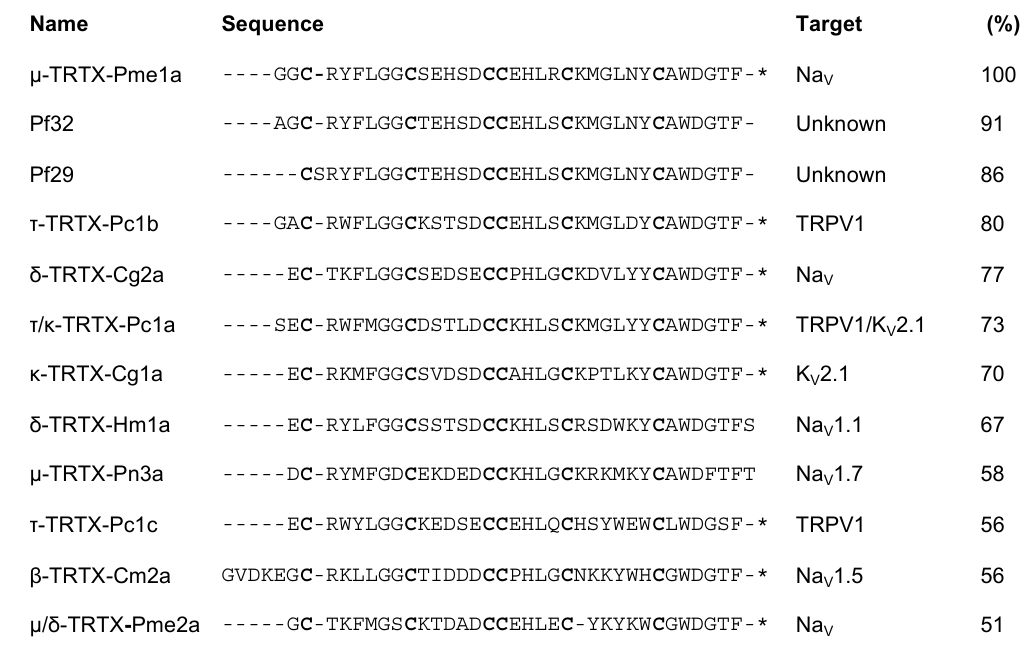
Figure 2. Sequence alignment of Pme1a and Pme2a. Sequence alignment of Pme1a and Pme2a with % sequence identity (to Pme1a) to selected mature spider peptides with a known target from Universal Protein Resource (www.uniprot.org) and two sequences identified from the venom gland of the related species P. formosa with unknown activity. Cysteine residues are shown in bold and * indicates amidated C-terminus. Pme1a and Pme2a align to spider peptides belonging to NaSpTx2 family 2.